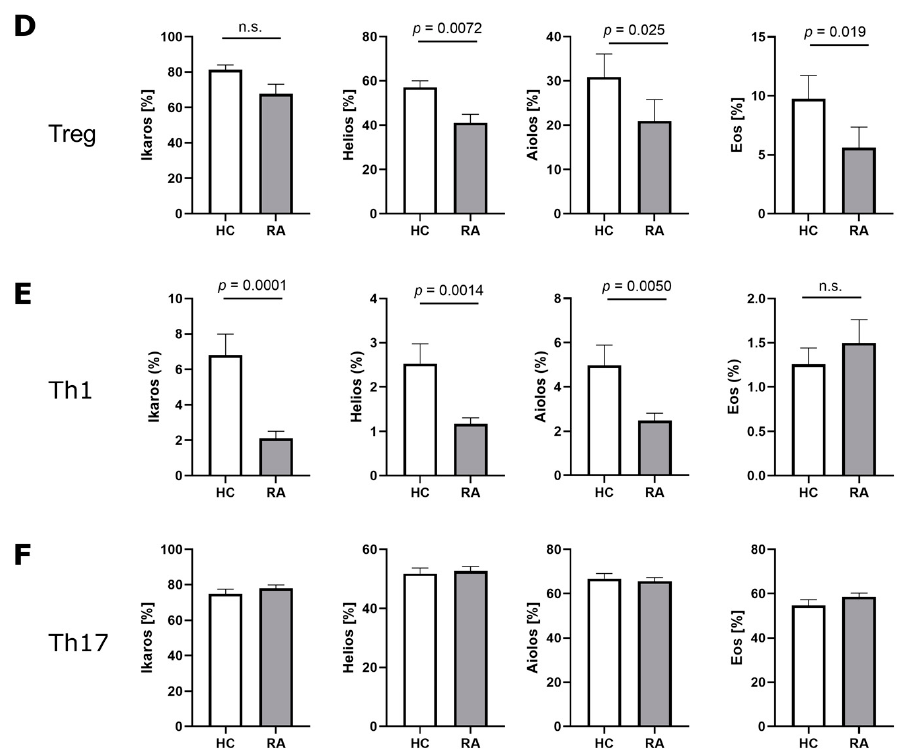
Figure 1. Ikaros zinc finger transcription factor expression in Treg cells, Th1 cells and Th17 cells from patients with RA. ( A ) Gating strategy for the identification CD127 low CD25 high FoxP3 + Treg cells. ( B ) Representative example of flow cytometry analysis of Ikaros, Helios, Aiolos and Eos in Treg cells from RA patients. ( C ) Representative example of IFN- γ and IL-17 analysis. ( D ) Ex vivo expression of Ikaros zinc finger family members in Treg cells, ( E ) Th1 cells and ( F ) Th17 cells from RA patients (RA; n = 20) and healthy controls (HC; n = 12). Significance was calculated using non-parametric Mann–Whitney test and results are presented as mean +/ − SEM.